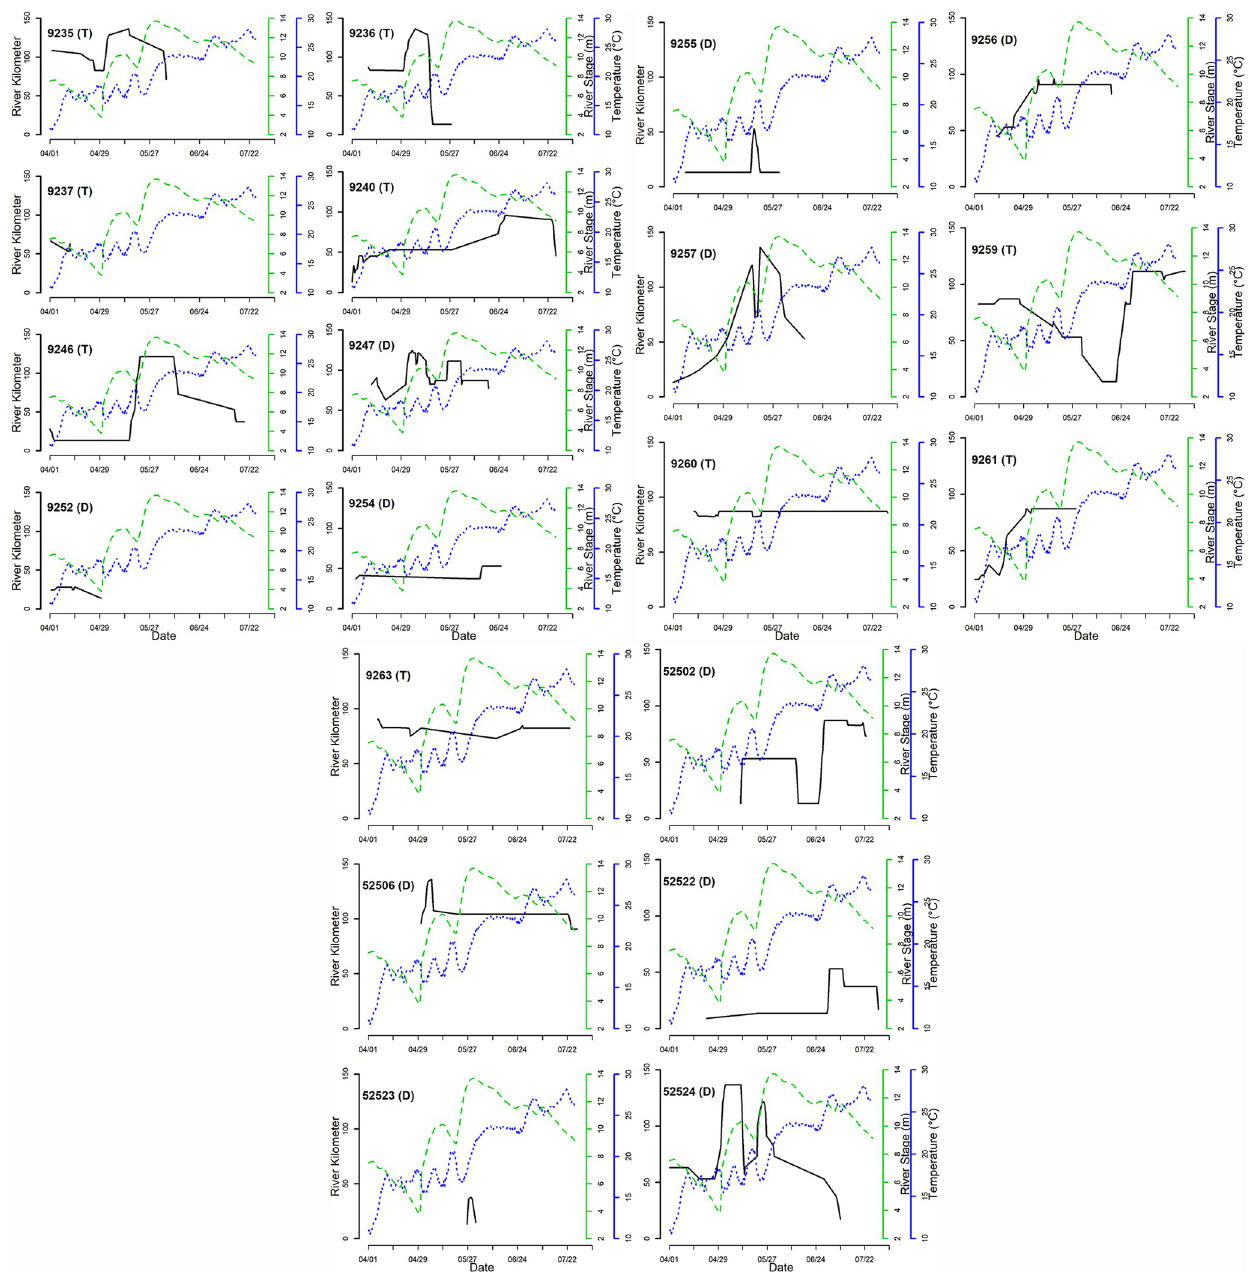
Fig 3. Movements of 20 tagged grass carp Ctenopharyngodon idella detected making upstream movements during the 2019 spawning season on the Osage River above Truman Reservoir, Missouri. The left y axis indicates distance in river kilometers (rkm) from the Truman Reservoir dam. The right y axes indicate river stage (m) and water temperature (˚C) on the Osage River at Taberville, MO (USGS gage 06918250). A lack of movement for fish around the confluence of the Sac River with the Osage River (rkm 80) may be an artefact of movement between the two rivers. Numbers in the top left of each plot indicate the fish’s unique tag ID and a “D” indicates diploids and “T” triploids, more information on individuals can be found in Table 1.